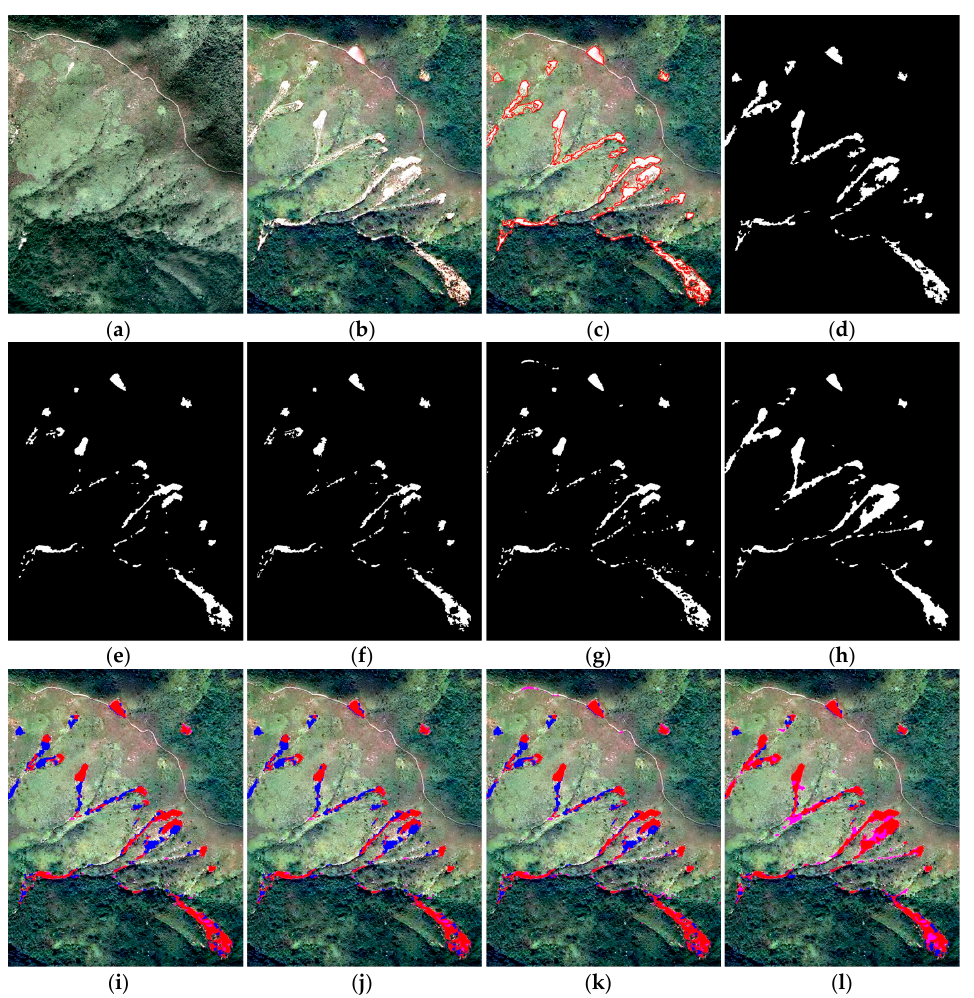
Figure 15. Experimental results on C-area: ( a ) pre-event image; ( b ) post-event image; ( c ) contour of ground truth on post-event image; ( d ) ground truth segmentation; ( e ) landslide regions obtained by ELSE; ( f ) landslide regions obtained by RLSE; ( g ) landslide regions obtained by CDMRF; ( h ) landslide regions obtained by the proposed CDFFCM; and ( i – l ) landslide mapping results using ELSE, RLSE, CDMRF, and CDFFCM overlaid on the post-event image, respectively.